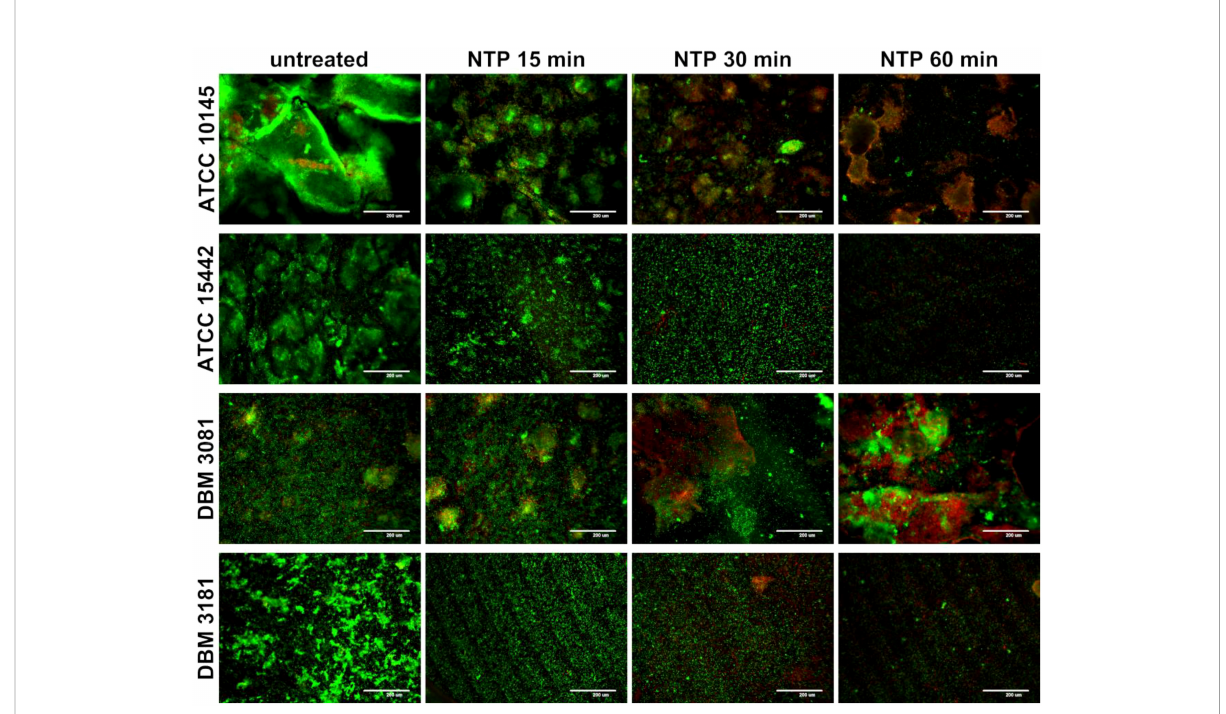
FIGURE 2 Effect of non-thermal plasma (NTP) on bio fi lm cells of four Pseudomonas aeruginosa strains visualized by spinning disc confocal microscope (SDCM) using SYTO13/propidium iodide (PI) overlay. Bio fi lm of P. aeruginosa ATCC 10145, ATCC 15442, DBM 3081 and DBM 3181 was formed on Ti-6Al-4V alloy coupons; green signal: all present cells (SYTO13); red signal: dead/disrupted cells (PI); scale bar = 200